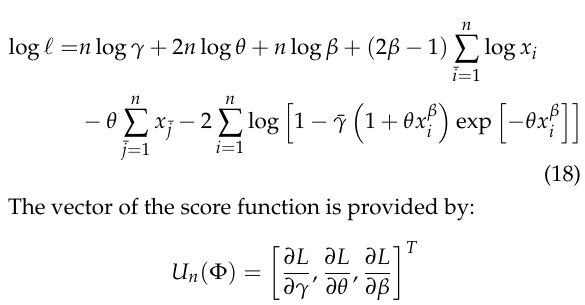
Fig. 5. The TTT plot of (a) Glass Fibers data and (b) Turbocharger